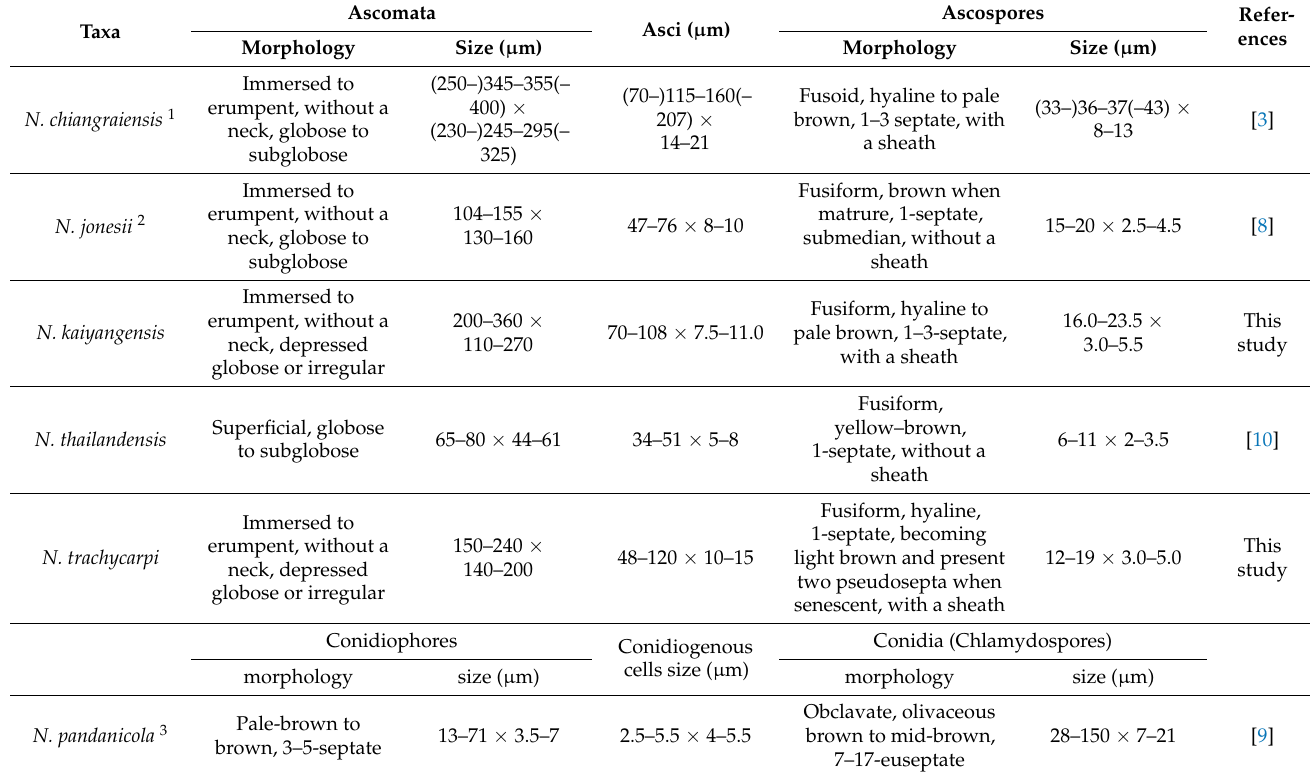
Table 2. Comparative morphological data on species of Neooccultibambusa